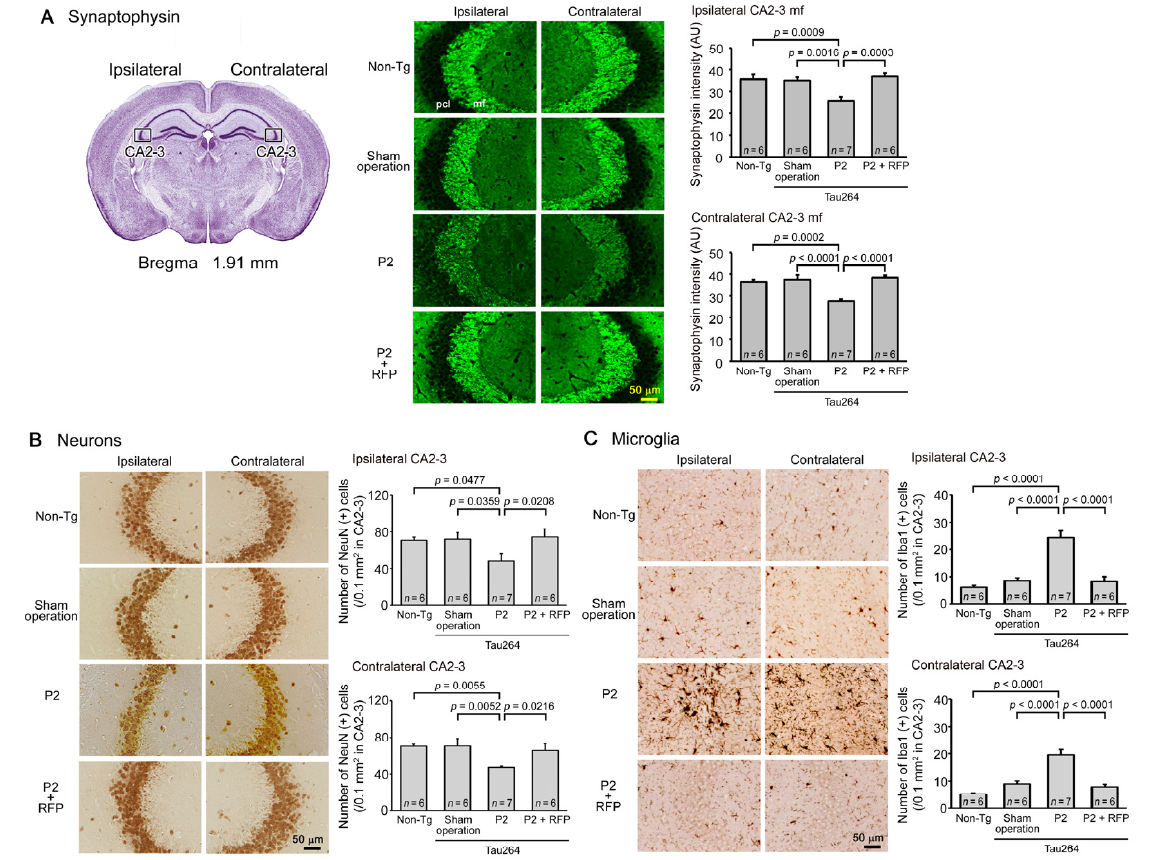
Figure 4. Loss of synapses and neurons and the effects of rifampicin treatment. Brain sections anterior to the injection site were examined for synapse and neuronal loss and microglial